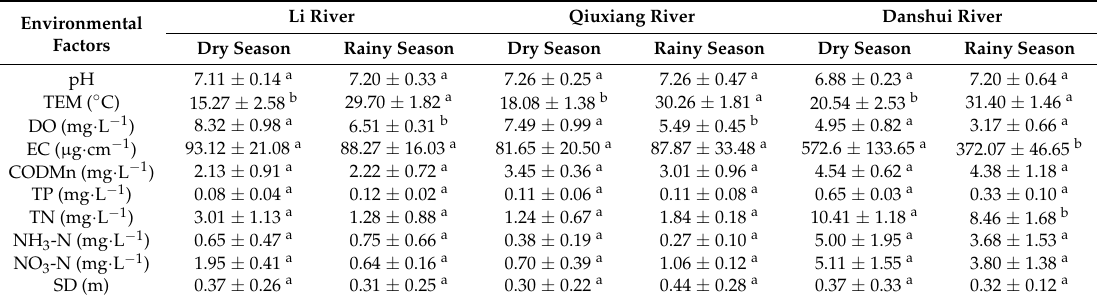
Table 1. Environmental factors in the three tributaries in the dry and rainy